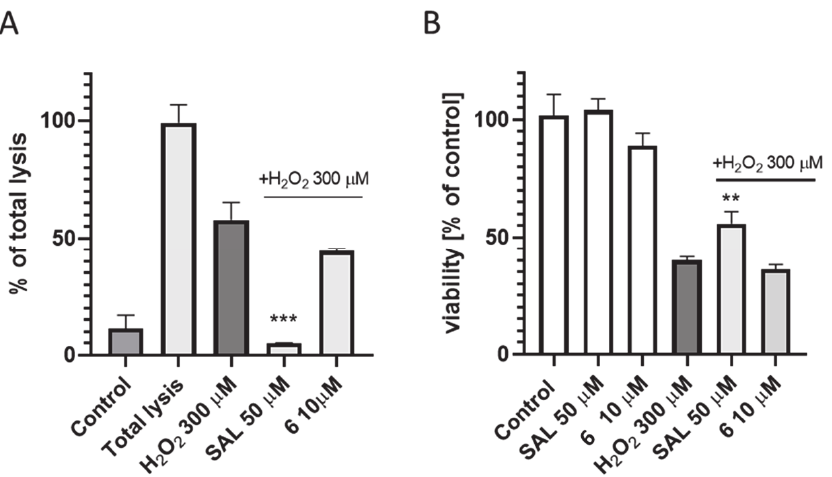
Figure 14. The effect of 6 at 10 µ M and salsolinol (SAL; as the reference neuroprotectant) at 50 µ M on SH-SY5Y neuroblastoma cells necrosis ( A ) and viability ( B ) damaged by 300 µ M of H 2 O 2 after 24 h of incubation. Statistical significance was set at *** p < 0.001, ** p < 0.01 by GraphPad Prism TM 8 software using One-way ANOVA and Bonferroni’s Multiple Comparison Post Test in comparison with the positive control H 2 O 2 (300 µ M).